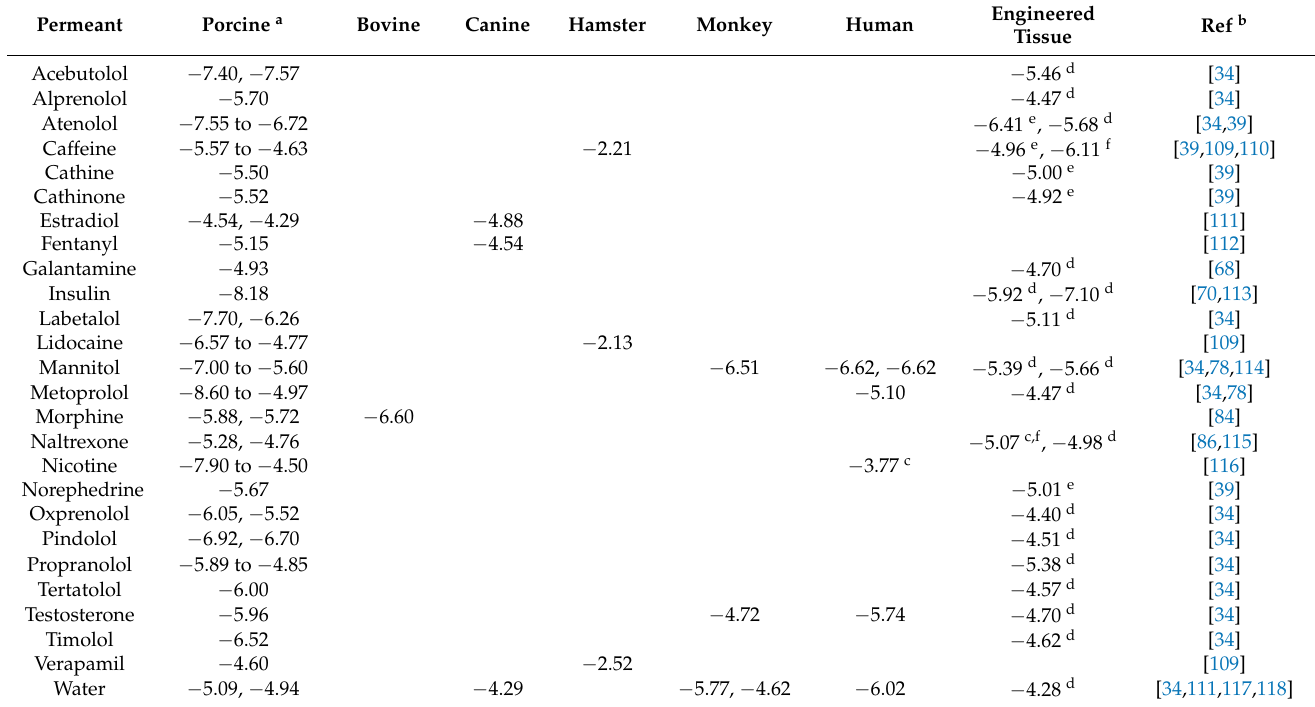
a Permeability value from Table A1. b References listed are for buccal tissues from other species and engineered tissues. References for porcine buccal tissue are listed in Table A1. c Multiple permeability values are available in the reference and the average value of log P